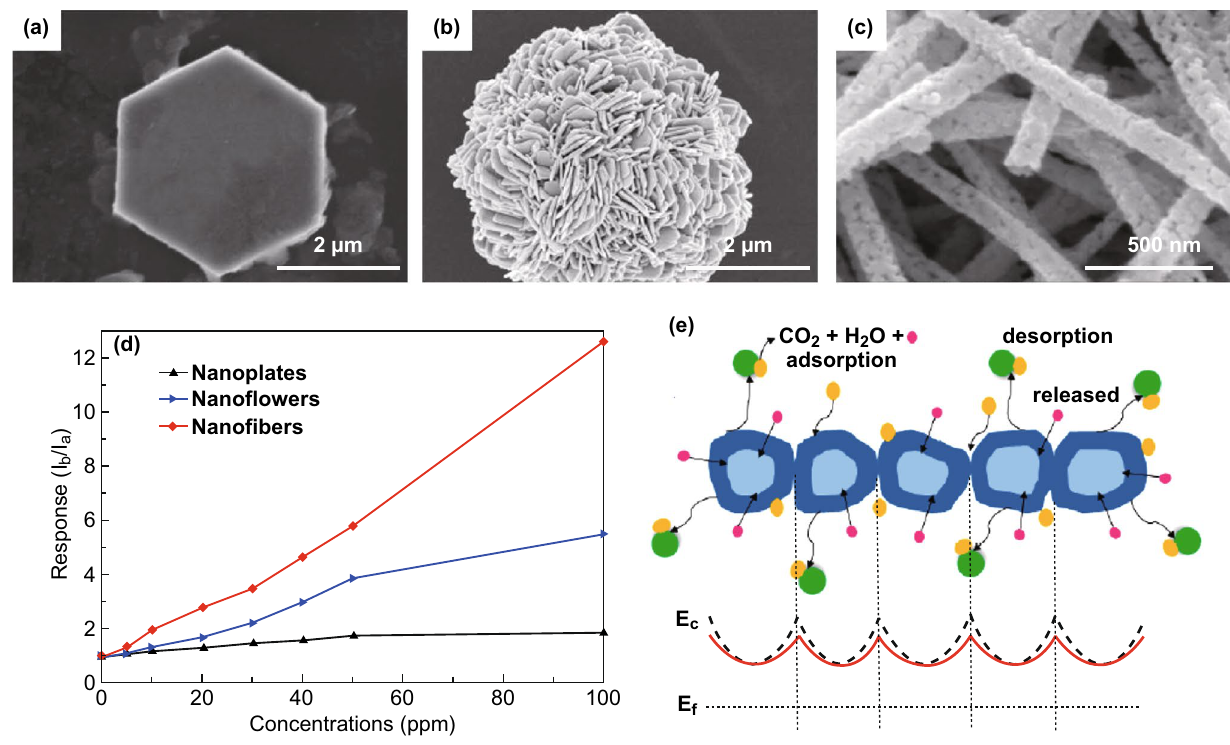
Fig. 1 SEM images of ZnO a nanoplates, b nanoflowers, c nanofibers. d Comparative plot of sensor responses for ZnO nanoplates, nanoflowers and nanofibers at RT under UV light. e Schematic sensing mechanism for the ZnO nanofibers to formaldehyde under UV irradiation. Repro- duced with permission [45]. Copyright 2015,